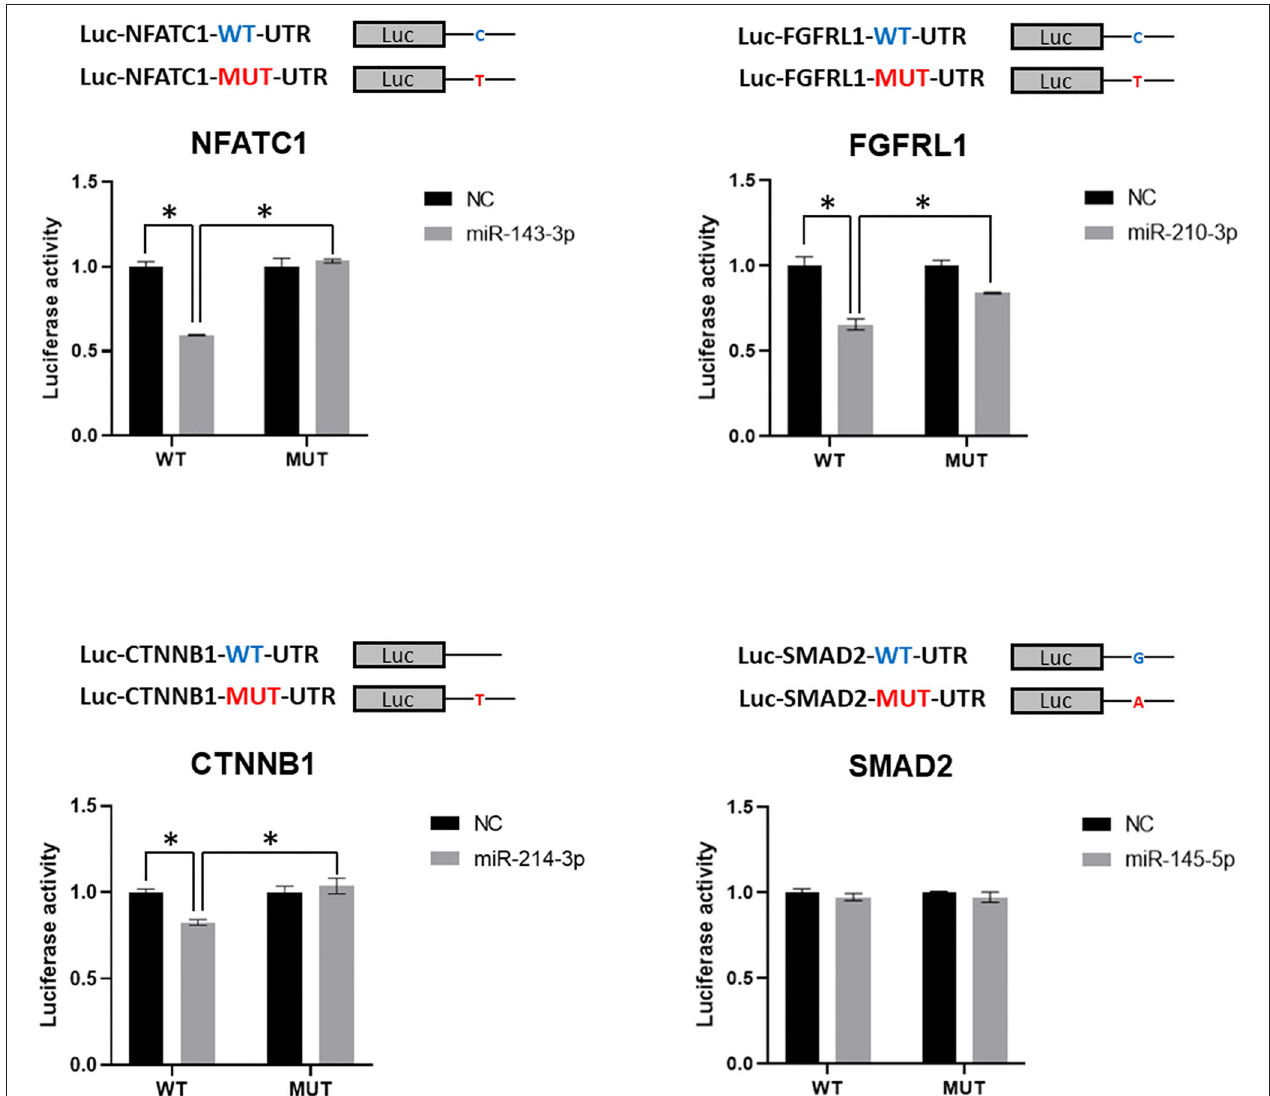
FIGURE 4 | Validation of miRNA-mediated dysregulation induced by SNVs. Luciferase reporter assay was applied in the validation. Luciferase reporters with wild-type or mutant 3 ′ UTR of selected genes were co-transfected with predicted miRNA mimics, which was predicted to target the tested 3 ′ UTR of gene, or negative control (NC), and luciferase activity was determined. Values are presented as relative luciferase activity ± SD relative to the luciferase activity of reporter co-transfected with negative control mimics. Data were obtained from at least three independent experiments. miRNA, microRNA; SNV, single-nucleotide variant. *indicates p <